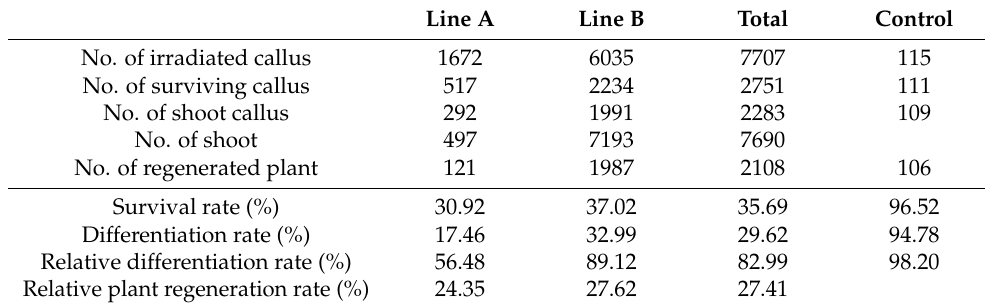
Table 2. Plantlet differentiation and plant regeneration of irradiated callus.